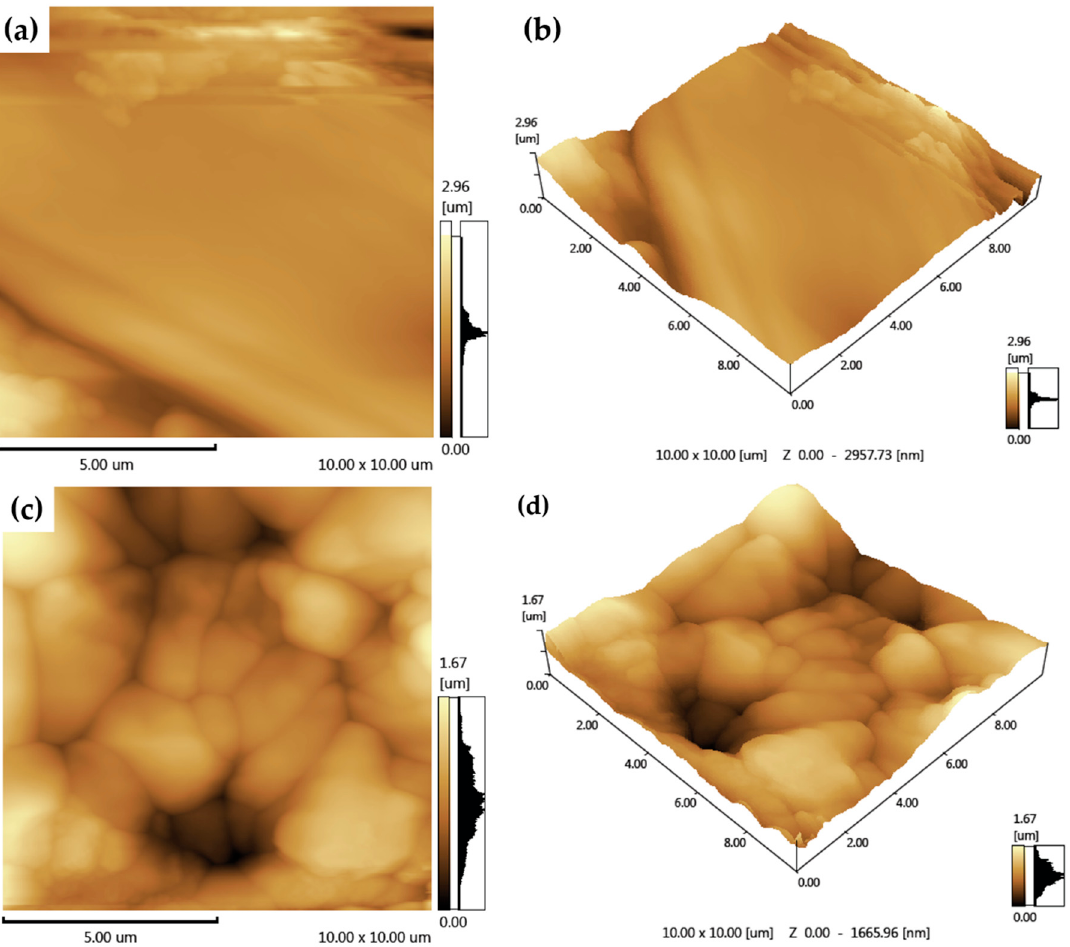
Figure 6. Two-dimensional and 3D topographic images of the films. ( a , b ) Two-dimensional and 3D atomic force microscopy (AFM) images of BF; ( c , d ) two-dimensional and 3D AFM images of CMHF.